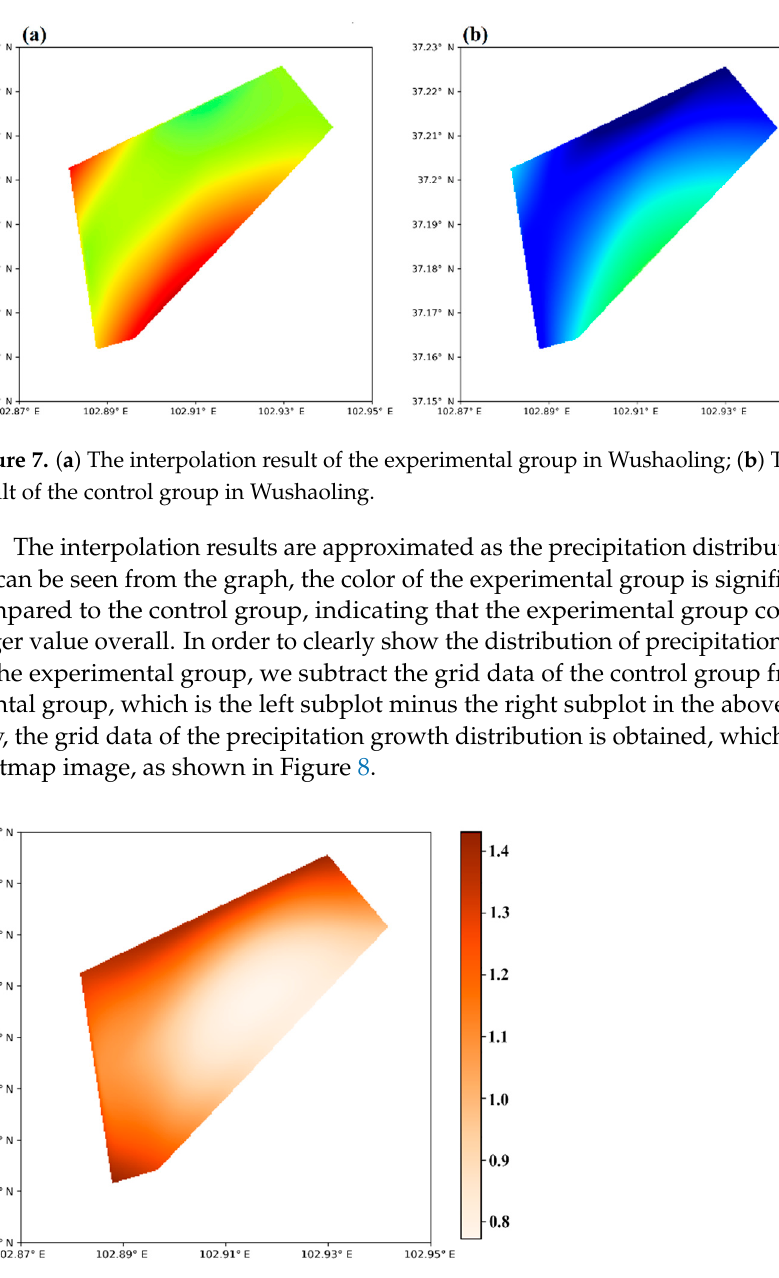
Figure 8. Heatmap of the Wushaoling area.